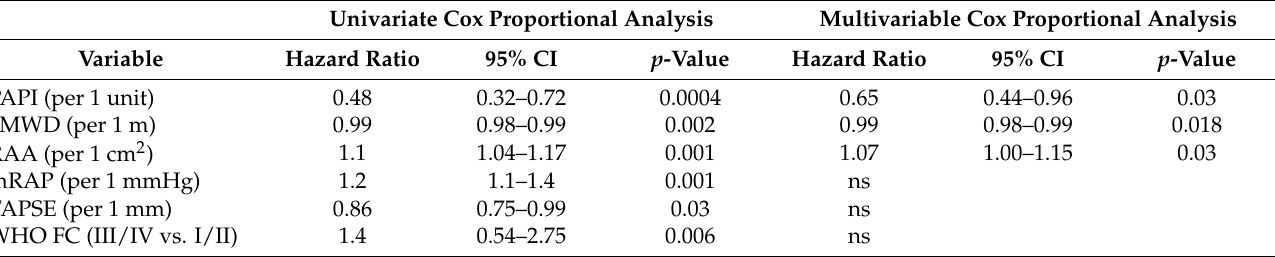
Table 3. Univariate and multivariable Cox proportional hazards regression analysis. Univariate Cox Proportional Analysis Multivariable Cox Proportional Analysis